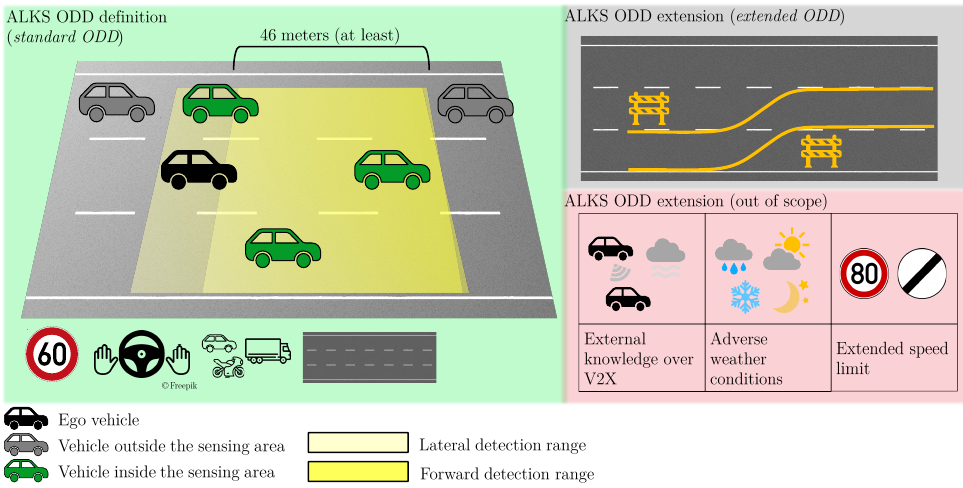
Figure 4. Overview of the required ODD for an ALKS, including potential extensions and out-of- scope